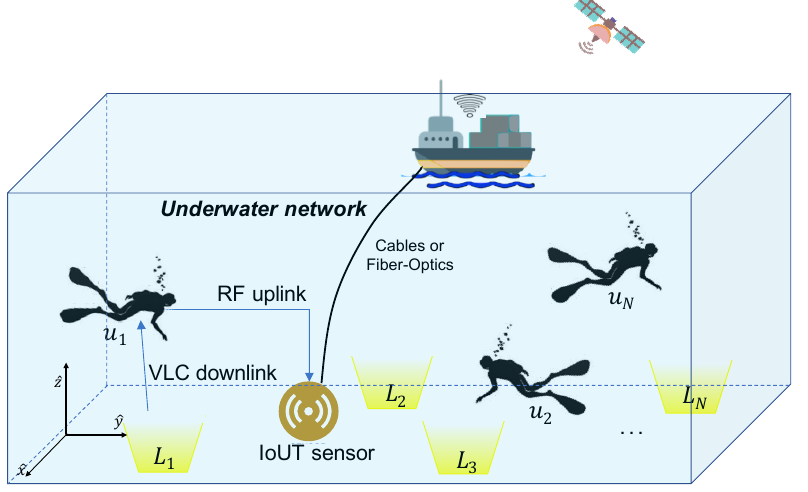
Figure 1. Schematic of a reference UVLC network, comprised of L N = 4 LED transmitters and a centralized RF IoUT sensor node. Wearable battery-powered photodetectors are assumed to be placed on the diver’s